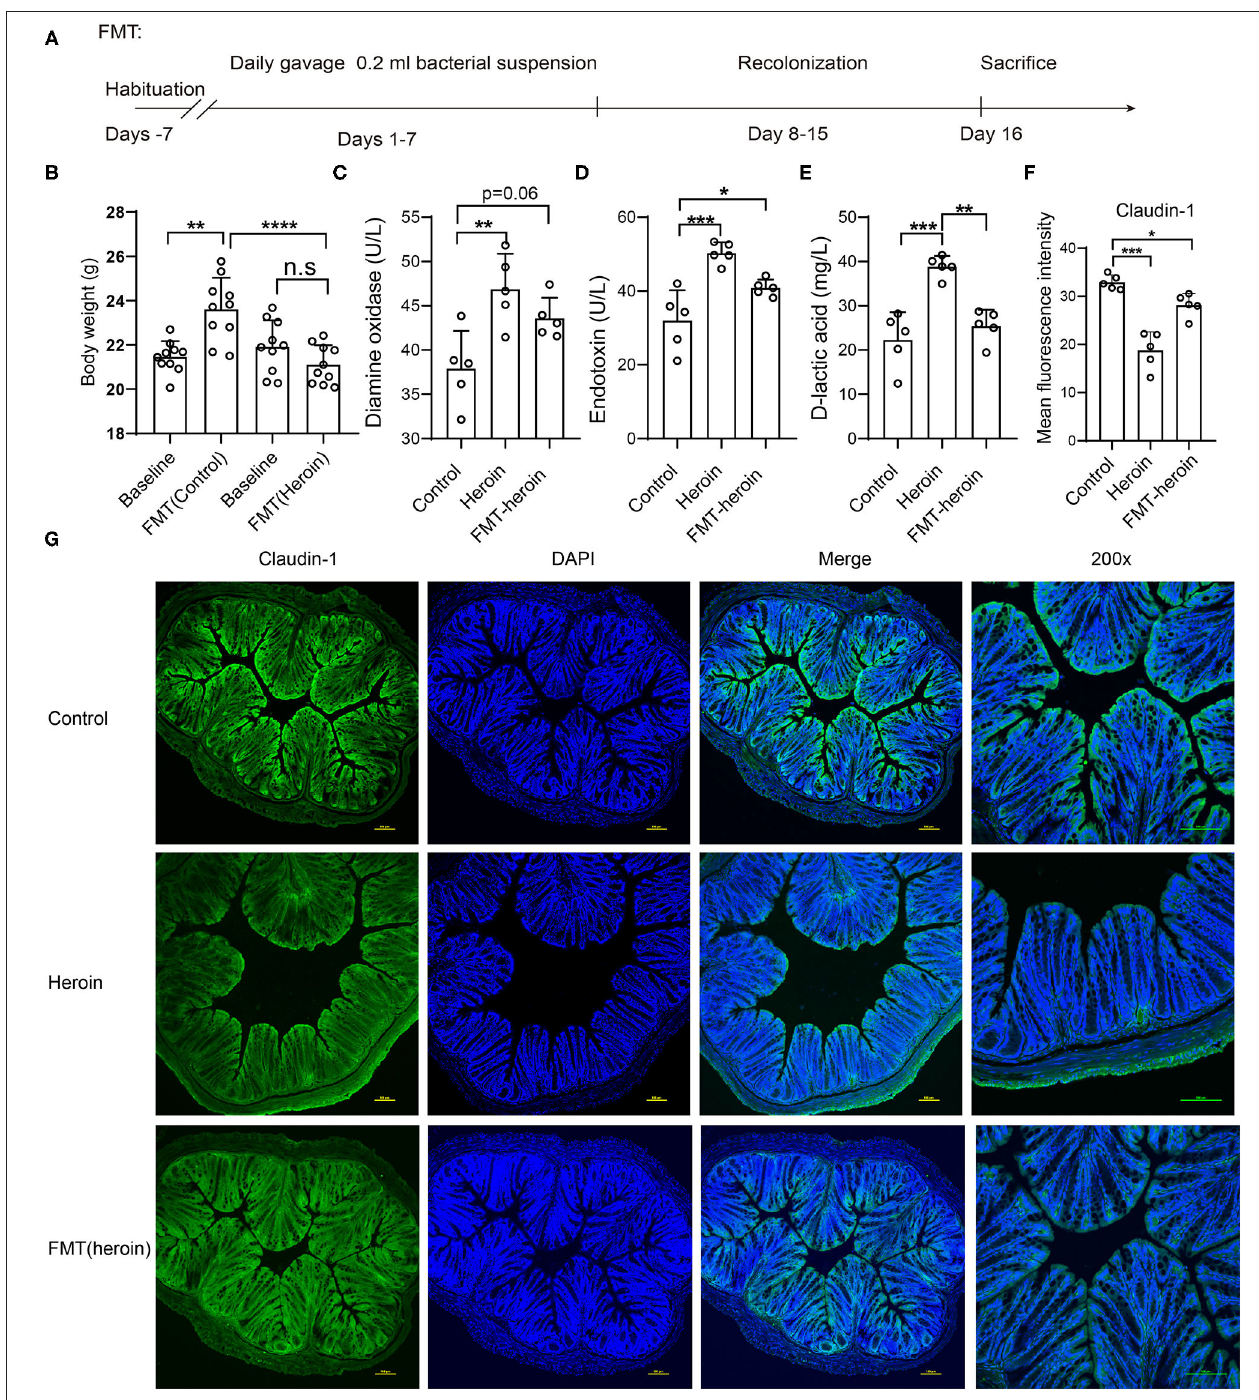
FIGURE 5 | Effect of FMT treatment on intestinal permeability and expression of tight junction proteins in mice. (A) Scheme of FMT experiment. (B) The body weight of pre-FMT and Post-FMT in receive control microbiota and heroin microbiota groups. (C–E) The serum levels of DLA, ET and DAO in control and FMT groups. (F,G) Immunofluorescence showed decreased expression levels of Claudin-1 in heroin and FMT groups. (F) Mean fluorescence intensity of Claudin-1 expression. (G) Example images. All data are expressed as the mean ± SD * p < 0.05; ** p < 0.01; *** p < 0.001; **** p < 0.0001. baseline levels after 7 days of methamphetamine cessation in align with our findings, and we speculated that increases in rat model (40). Additionally, a higher level of Bifidobacteriaceae relative abundance of these gram-positive bacteria may act was found in major depressive disorder (41). These results as a protective mechanism against heroin acute